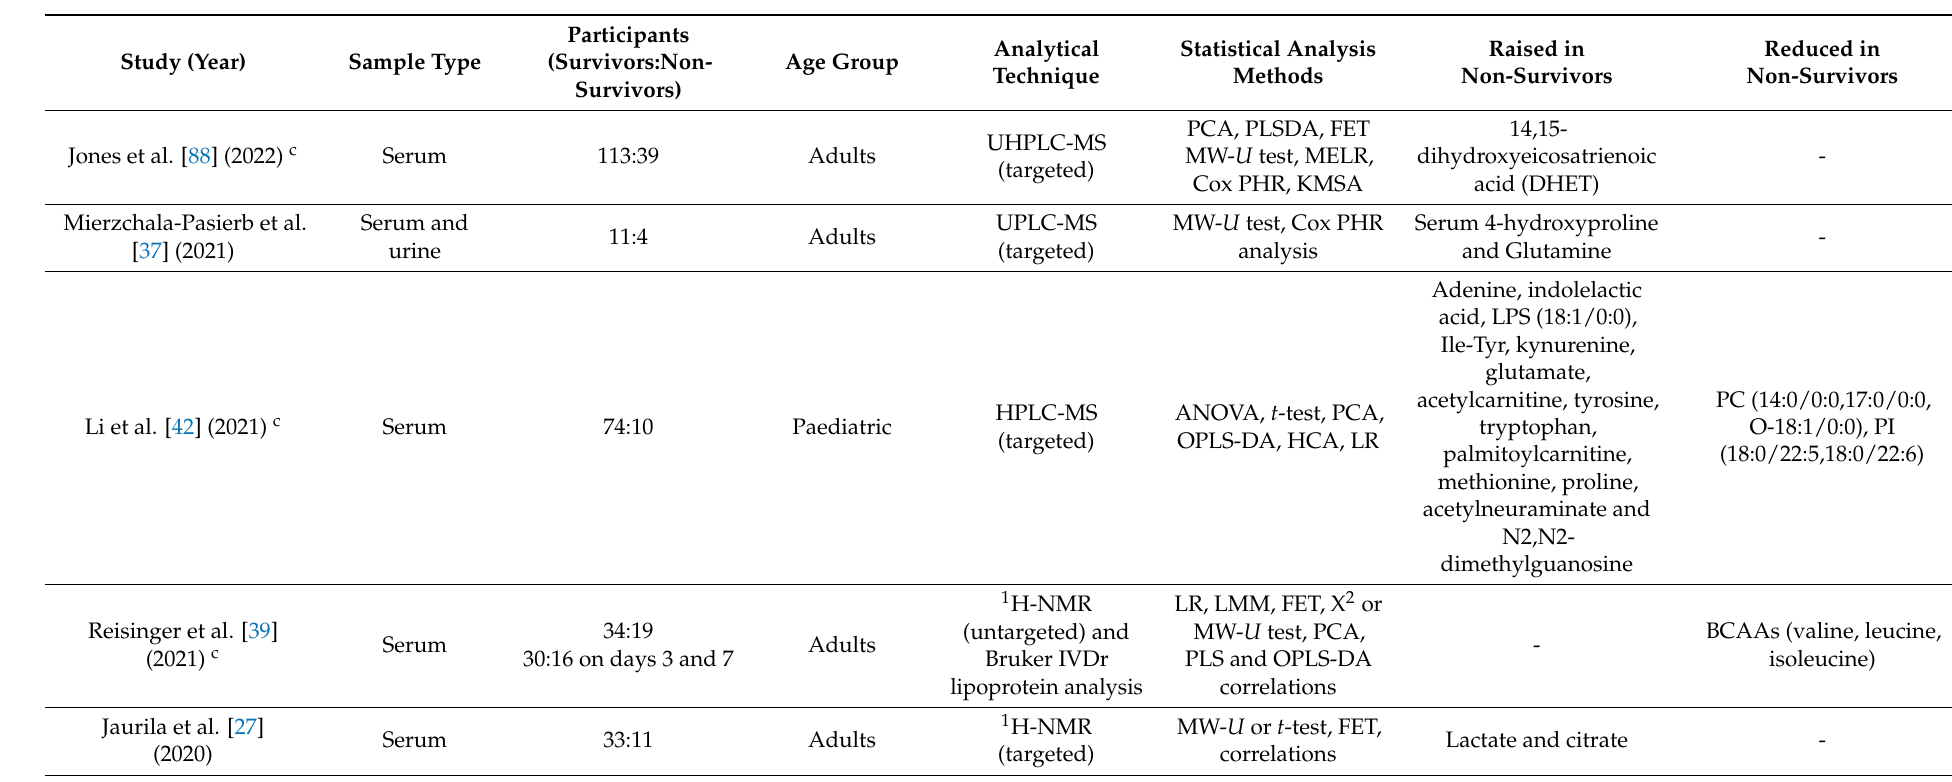
Table 2. Metabolomics studies of sepsis focusing on